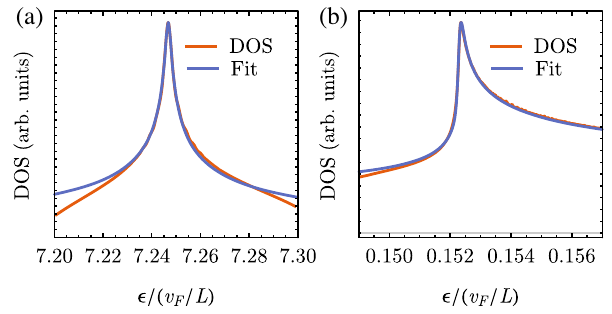
FIG. 6. (a) DOS of the relevant bands around the high-order Dirac point. The fitting is given by N ð ϵ Þ ¼ c j ϵ − ϵ 0 j ν þ n , where c ¼ 0 . 047 , ϵ 0 ¼ 7 . 25 , ν ¼ − 0 . 33 , and n ¼ 0 . 89 . (b) DOS of the relevant band around the high-order VHS of class A 2 . The fitting is given by N ð ϵ Þ ¼ C j ϵ − ϵ 0 j ν [see Eq. (3) for definition] with (cid:3) C − ¼ 0 . 35 , C ¼ 1 . 82 C − , ϵ 0 ¼ 0 . 152 , and ν ¼ − 0 . 20 . Both ν þ =C − agree well with the theoretical prediction. and C þ